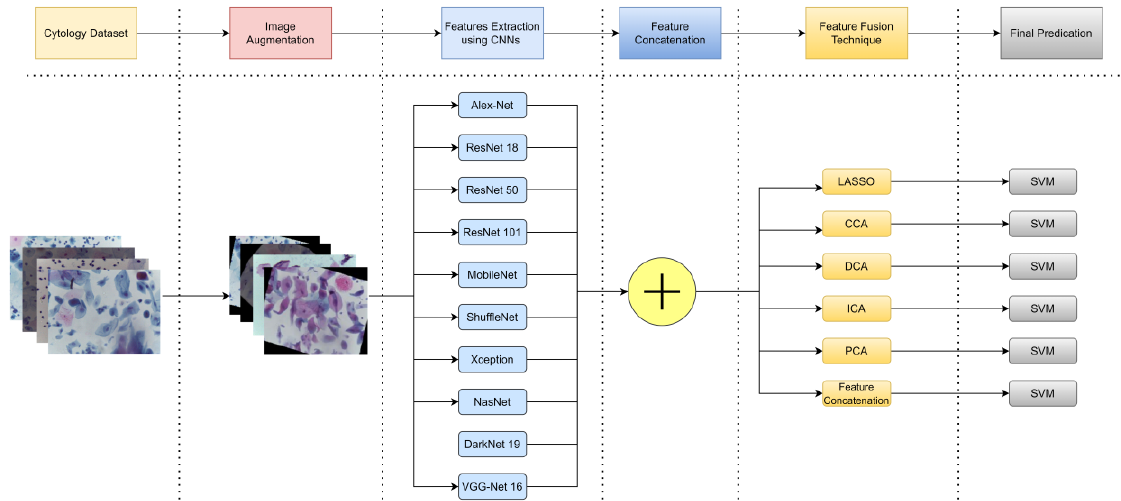
Figure 1. The proposed method. Showing all sequential steps of the proposed methodology in this paper.